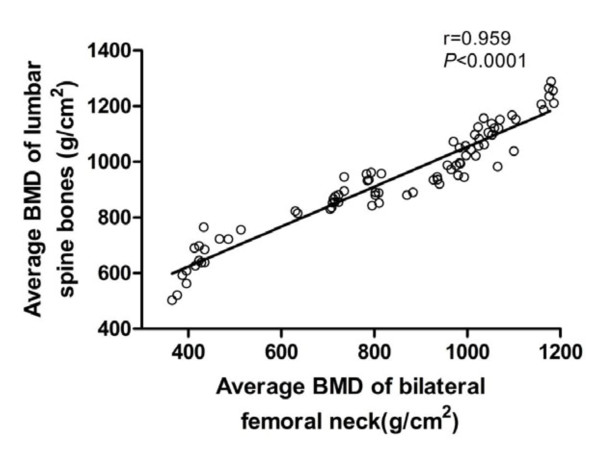
Relationship between the average BMD of lumbar spine bones and bilateral femoral necks. The average BMD of femoral neck showed a good correlation with lumbar vertebra (Average BMD of lumbar spine bones = 0.718 × Average BMD of bilateral femoral necks +336.46;r = 0.959; p < 0.0001).